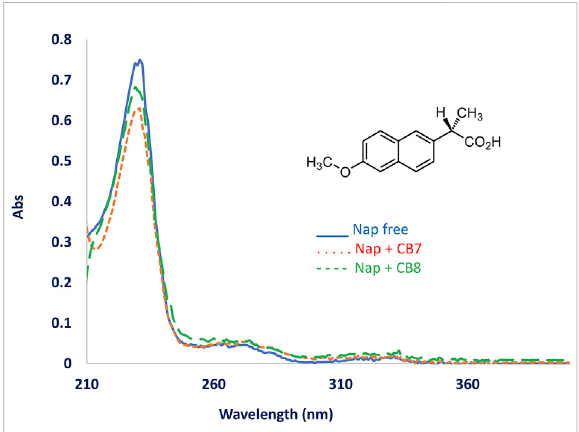
FIGURE 1 UV-Vis spectra of naproxen in aqueous solution without addingCBs(Bluesolidline)andafteraddingCB[8](dottedline)and CB[7]. Naproxen structure is shown at the fi gure